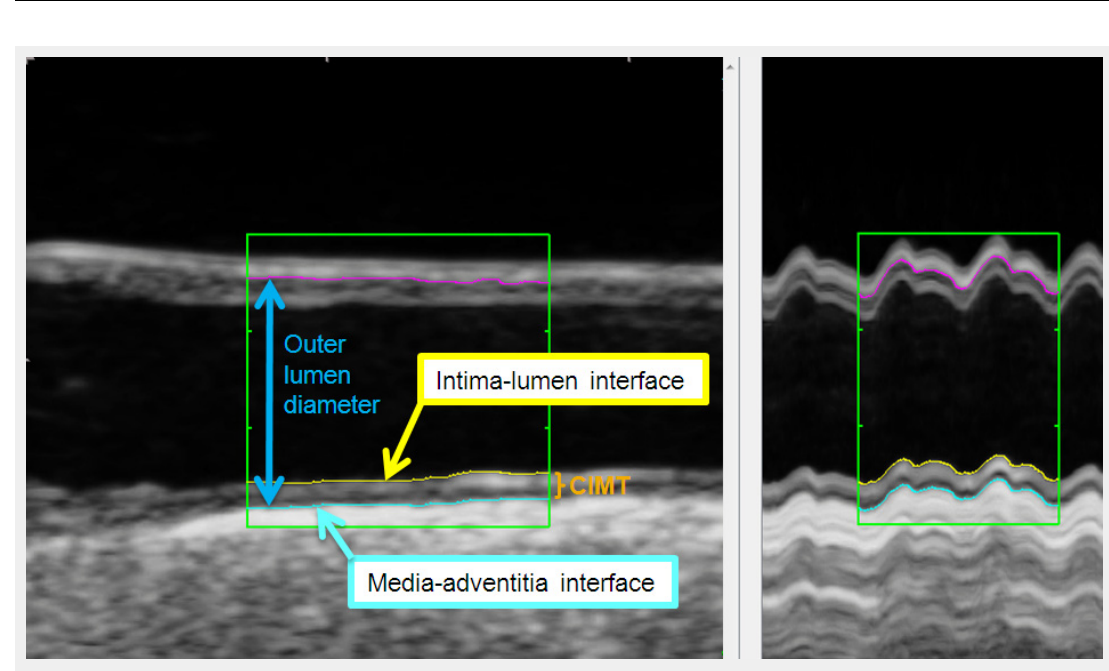
Figure 1 Ultrasound image of the common carotid artery (longitudinal axis) with tracing lines of automatic contour-detection at the lumen-intima- (yellow line) and the media- adventitia interface (blue line). Outer lumen diameter (between blue- and pink-coloured line) in the common carotid artery in B-mode (left) over two heart cycles and with M-mode (right) generated by 180 single images of a this clip. The mean CIMT at the far wall was 0.87 mm.